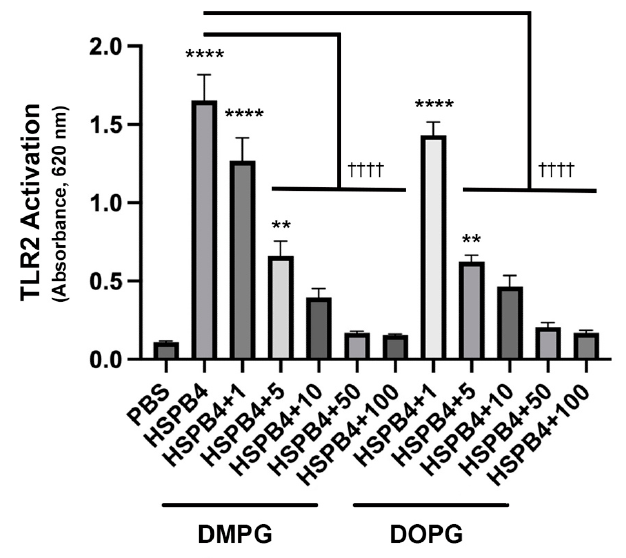
Figure 8. DMPG and DOPG both inhibited HSPB4-induced TLR2 activation. HEK-Blue-hTLR2 reporter cells were incubated with 1 µg/mL HSPB4 in the presence or absence of various concentrations of DMPG or DOPG as indicated (in µg/mL). In the presence of HSPB4, there was no significant difference in inhibition of HSPB4-mediated TLR2 activation between corresponding doses of DMPG and DOPG, and DMPG alone did not affect TLR2 activation. The activity of secreted alkaline phosphatase was measured as absorbance at 620 nm. Experiments were performed on three separate occasions, with results representing the means ± standard error of the mean. ** p < 0.01, **** p < 0.0005 versus the PBS control; †††† p < 0.0005 as indicated, using ANOVA with Tukey’s post-hoc testing. hTLR2, human toll-like receptor-2; PBS, phosphate-buffered saline; DMPG, dimyristoyl- phosphatidylglycerol; DOPG, dioleoylphosphatidylglycerol; HSPB4, heat shock protein B4.